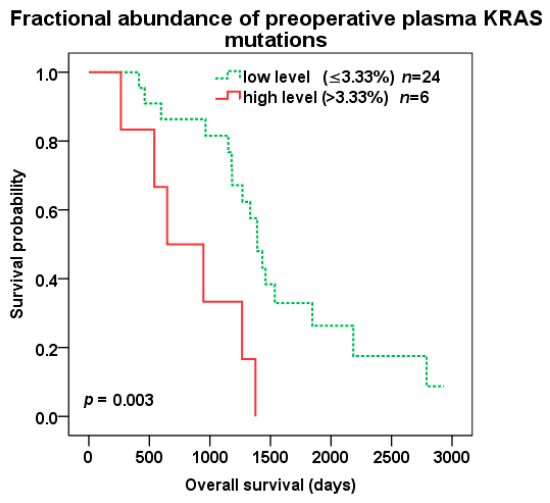
Figure 3. Disease-free survival (DFS) after liver surgery in patients with KRAS positive (red color) vs. negative (green color dotted line) pre-operative plasma samples.